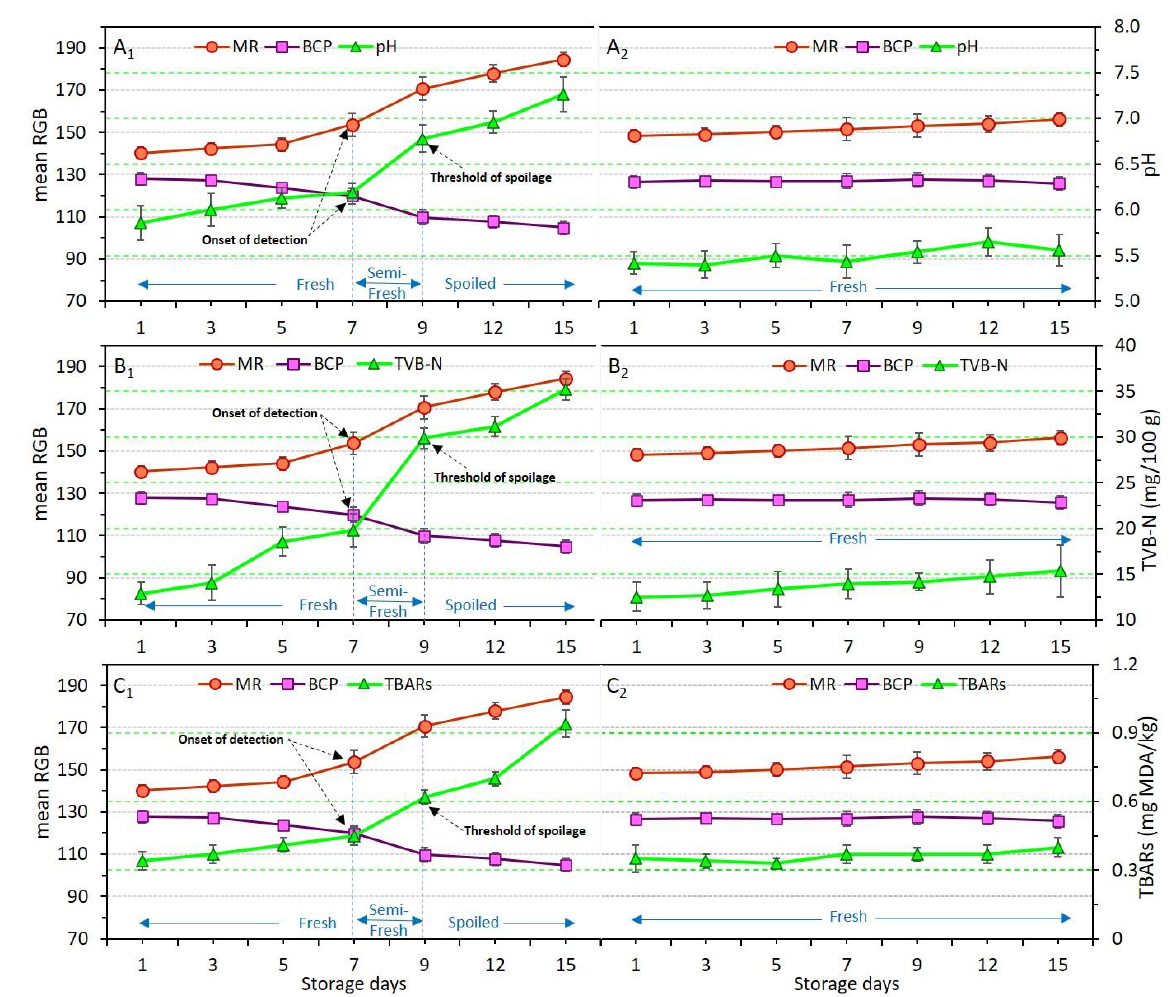
Figure 6. Variations of pH ( A ), TVB-N ( B ), and TBARs ( C ) values in relation to dual-sensors color responses (measured as mean RGB) in chicken meat samples without coating (control, ( A1 – C1 ) and coated with chitosan incorporating YEO (Ch_2% — YEO_0.3%, ( A2 – C2 )) during chilled storage days. Data are mean of at least triplicate measurements and error bars indicate SDs. MR: methyl red, BCP: Bromocresol purple. Onset of detection and threshold of spoilage in relation to pH, TVB-N, and TBARs values has been shown by black arrows.